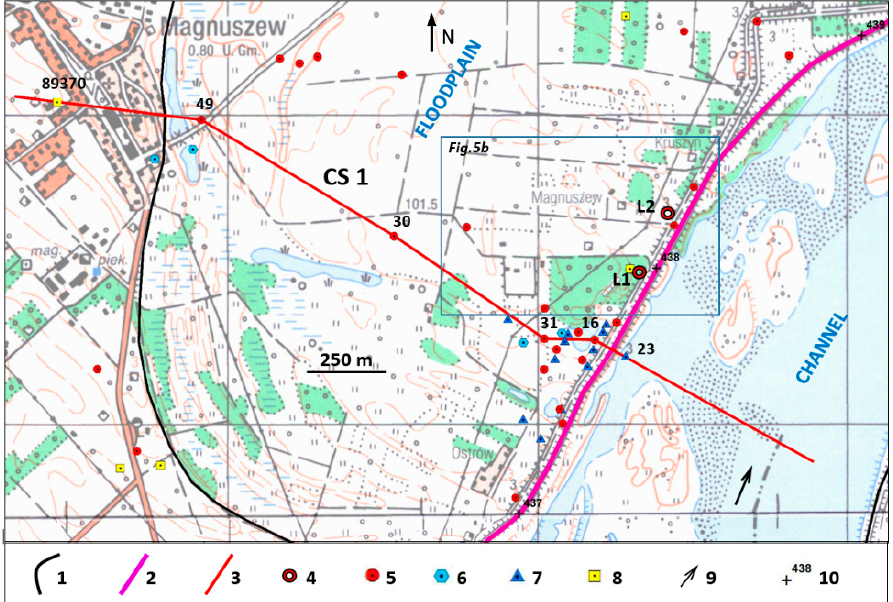
Figure 3. Line of the geological cross-section located in Figure 4. 1—border line of the area, 2— embankments, 3—line of cross-section, 4—data loggers, 5— drillings, 6—water gauge, 7—shallow piezometers. 8—archive drillings, 9—Vistula flow direction, 10—kilometer of the river.